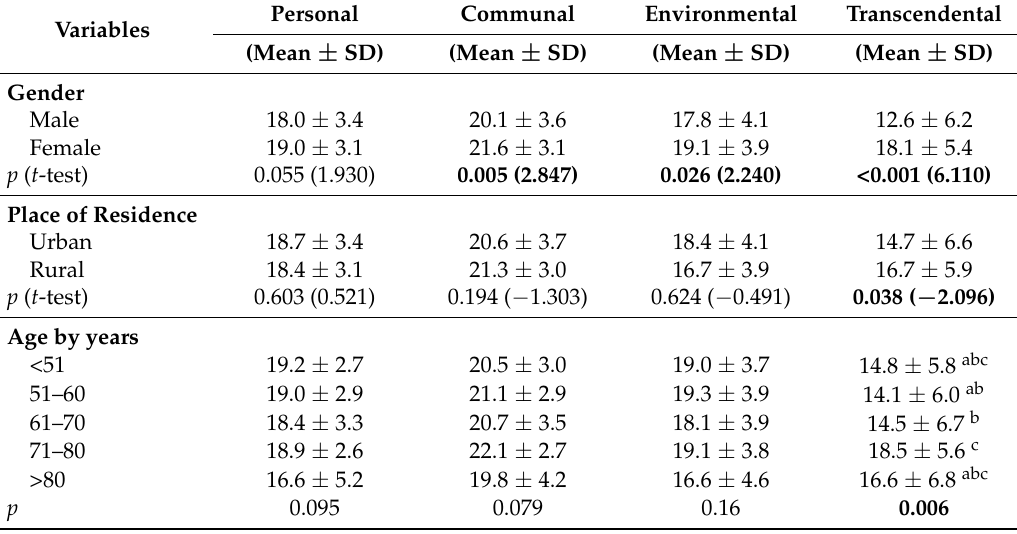
Table 6. Comparison of SHALOM–Lived Experience by sociodemographic characteristics (N =